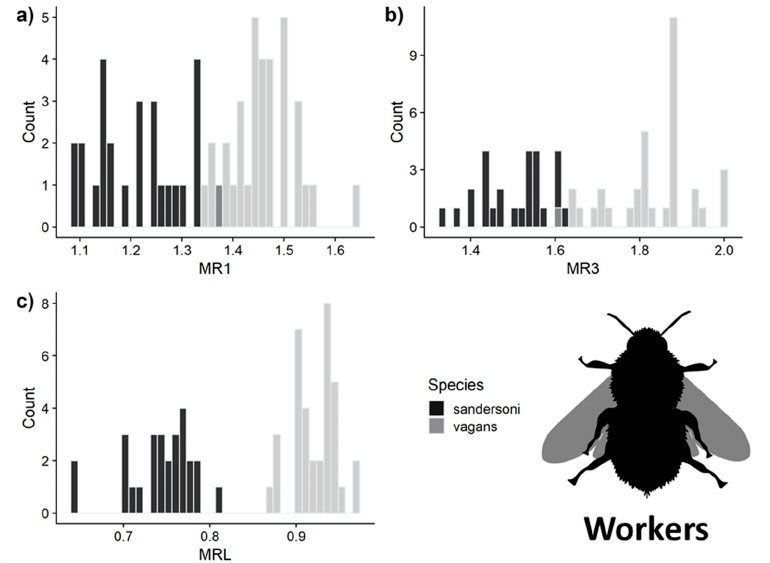
Figure 5. Distribution of malar ratio measurements of workers used in the LDA for ( a ) MR1, ( b ) MR3 and ( c ) MRL. Measurement accuracy ranged from 95–100%. Image from phylopic.org.